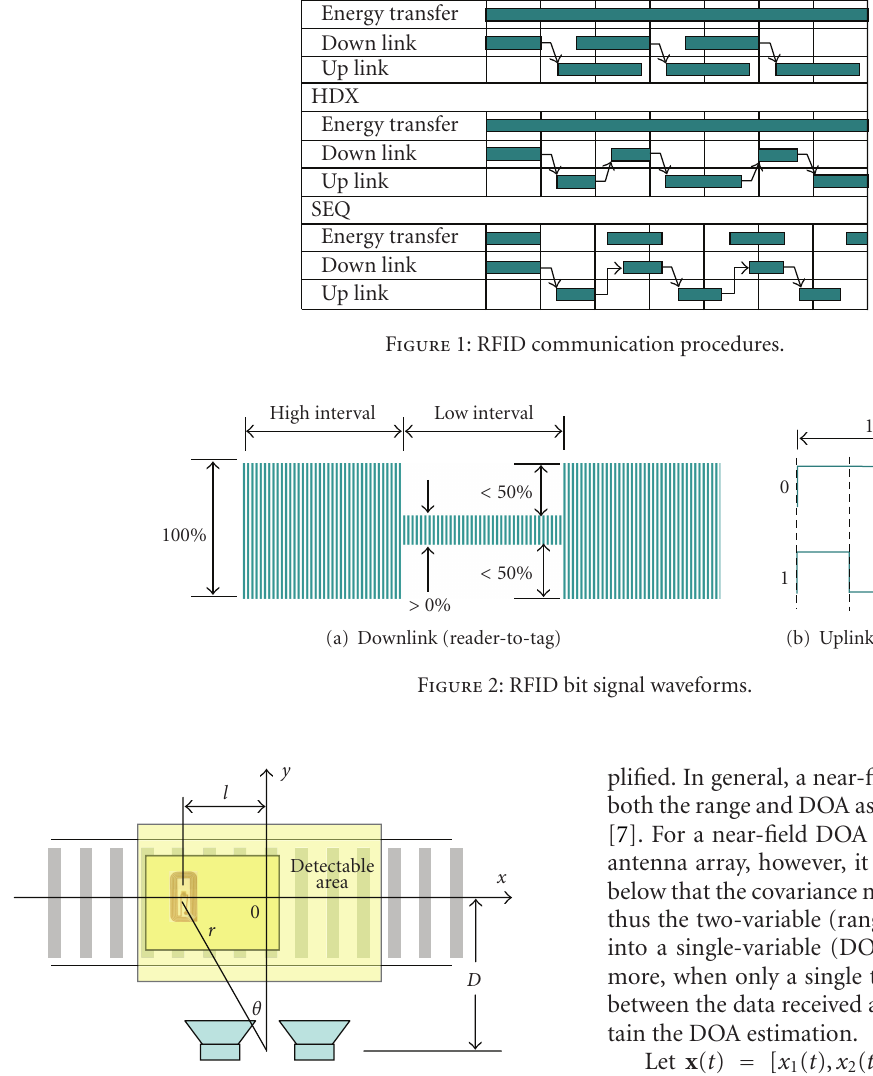
Figure 3: Geometry of the array